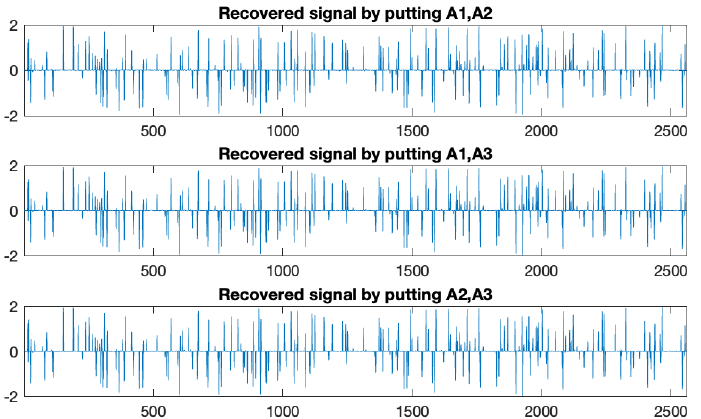
Figure 15. The recovered signal with m = 210 by A1A2 (78 Iter, CPU = 1.5538), A1A3 (82 Iter, CPU = 1.3578), and A2A3 (75 Iter, CPU = 1.2515),